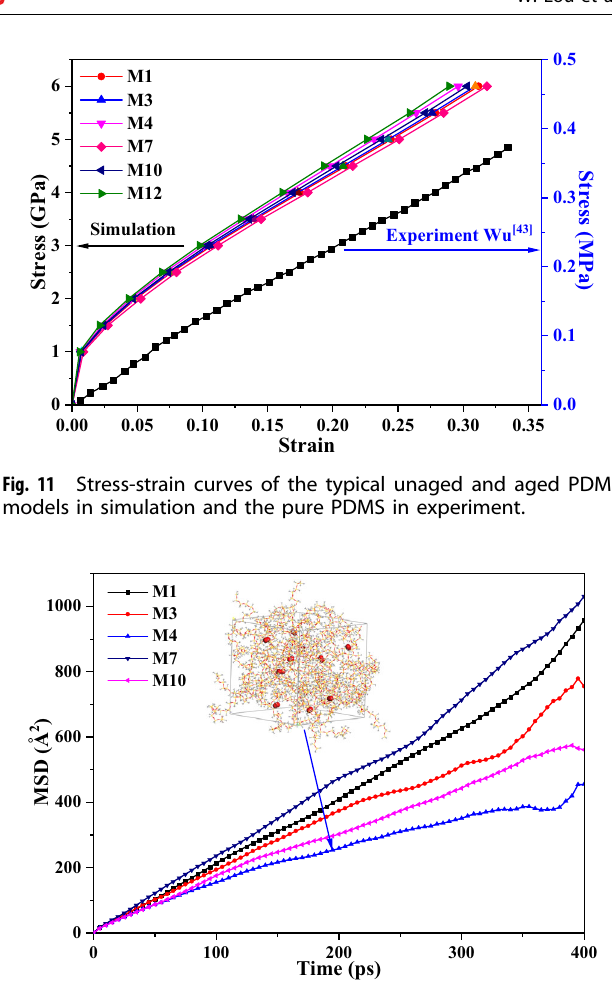
Fig. 12 MSDs of O 2 molecules in the unaged and aged PDMS models at 298 K as a function of simulation